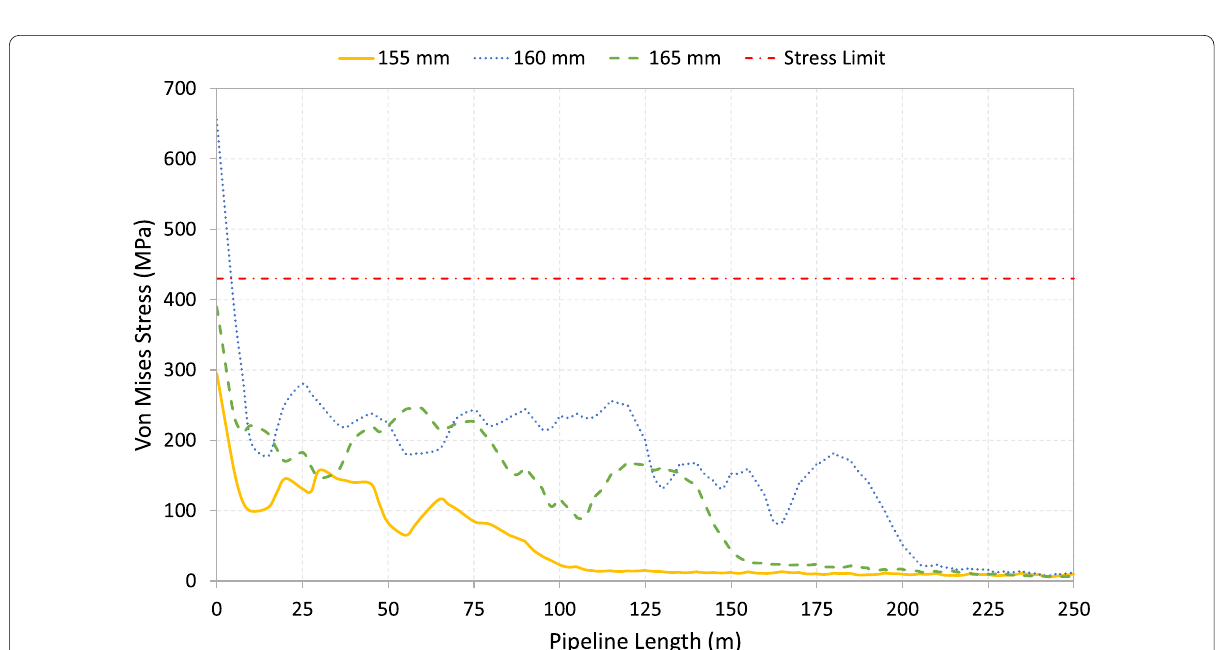
Fig. 8 Envelopes of the von Mises stresses of the pipeline for concrete thickness range 155–165 mm (10-year RPV wave